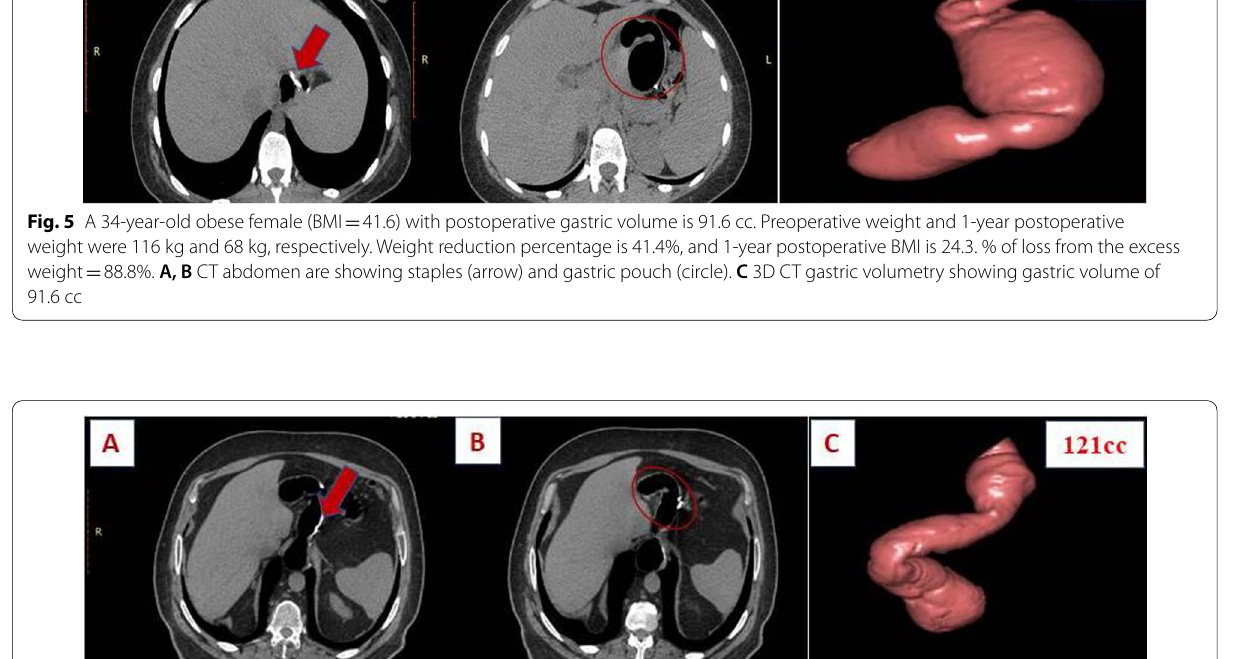
which means that the stomach volume does not have a direct impact on the body weight. The correlation between body weight reduction percentages (the per- centage of body weight reduction were 15%. (7%-24%)) and gastric volume reduction percentage [percentage of operative gastric volume reduction were 84% (76%-98%)], in the investigated cases is found to be insignificant.